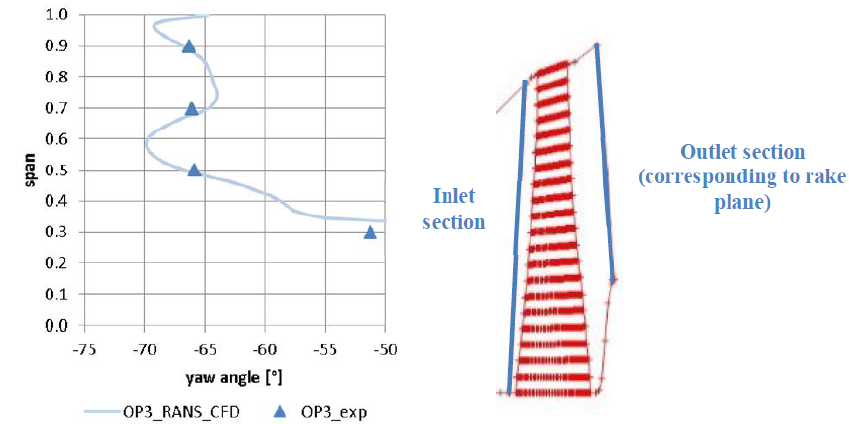
Figure 12. Matching of yaw angle measurement at LSB TE in OP3 (left) and meridional view of LSB CFD domain